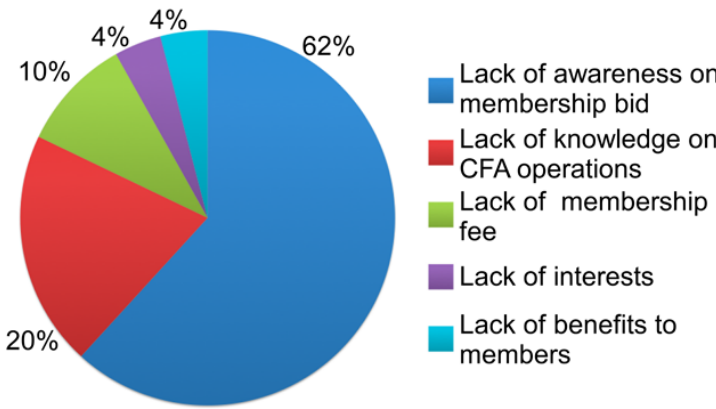
Figure 6. Factors hindering people from joining CFAs as of 2015, identified by the questionnaire survey ( n = 123).